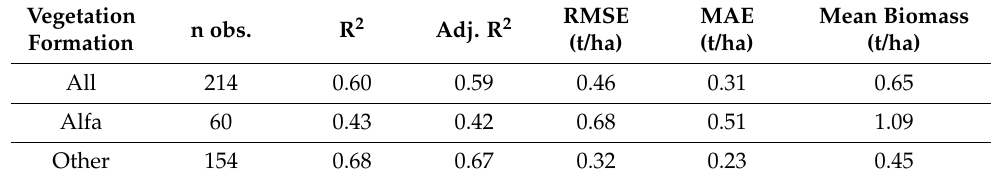
Table 6. Performance metrics of the linear models for the different types of vegetation formations. Vegetation n Formation